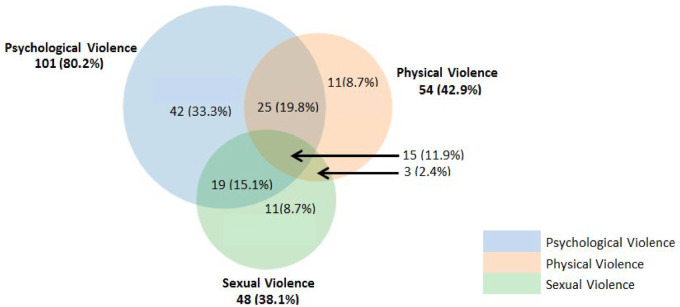
Intersections of the types of IPVp among survivors of IPVp in women giving birth at MTRH, April to June, 2017